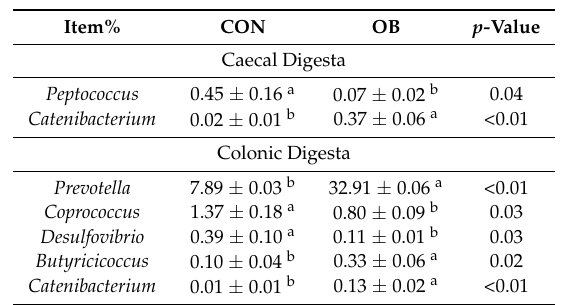
Table 3. The different abundant genera in the caecal and colonic digesta of pigs fed either control or oat bran diet 1